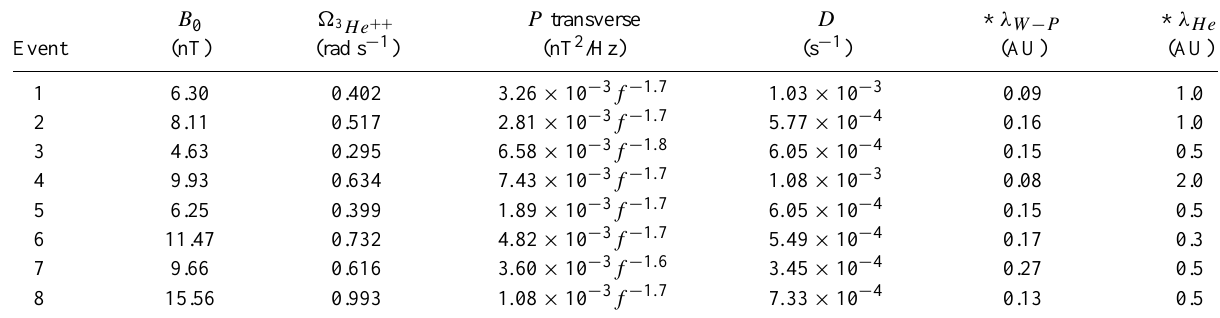
Table 4. Mean free paths for 1MeV/nuc 3 He ions of the 3 He-rich scatter-free events ( V He = 1 . 385 × 10 9